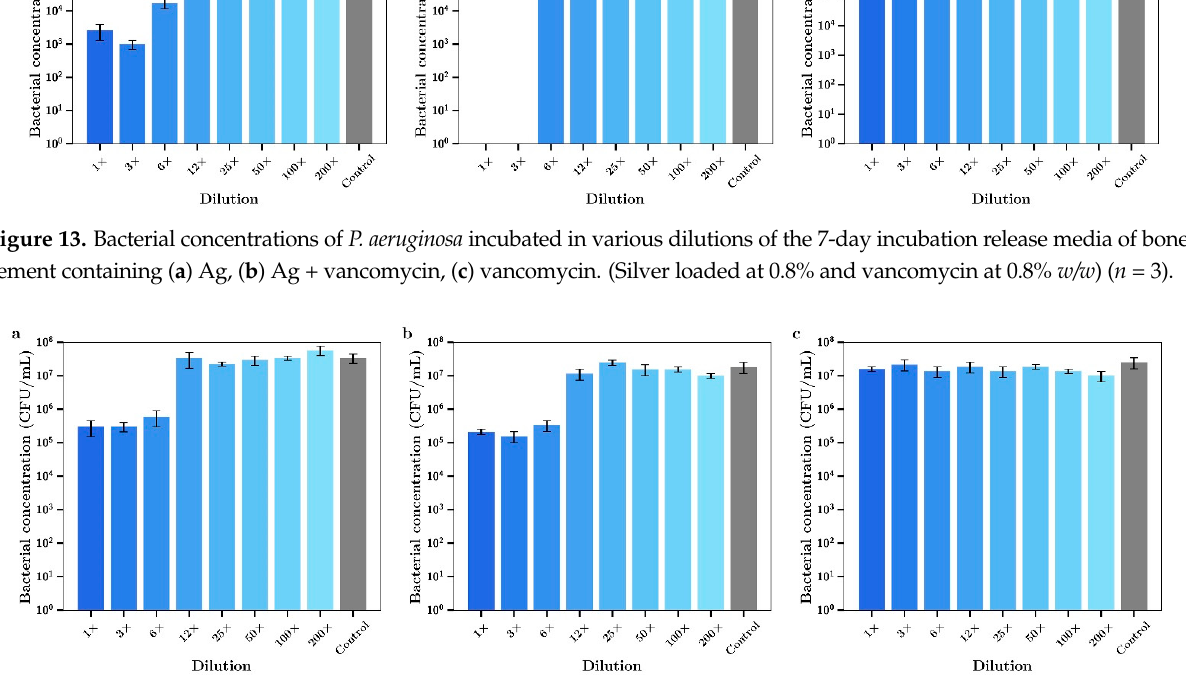
Figure 13. Bacterial concentrations of P. aeruginosa incubated in various dilutions of the 7-day incubation release media of bone cement containing ( a ) Ag, ( b ) Ag + vancomycin, ( c ) vancomycin. (Silver loaded at 0.8% and vancomycin at 0.8% w/w ) Figure 14. Bacterial concentrations of S. aureus incubated in various dilutions of the 7-day incubation release media of bone cement containing ( a ) Ag, ( b ) Ag + tobramycin, ( c ) tobramycin. (Silver loaded at 0.8% and tobramycin at 0.8% w/w ) ( n = 3).